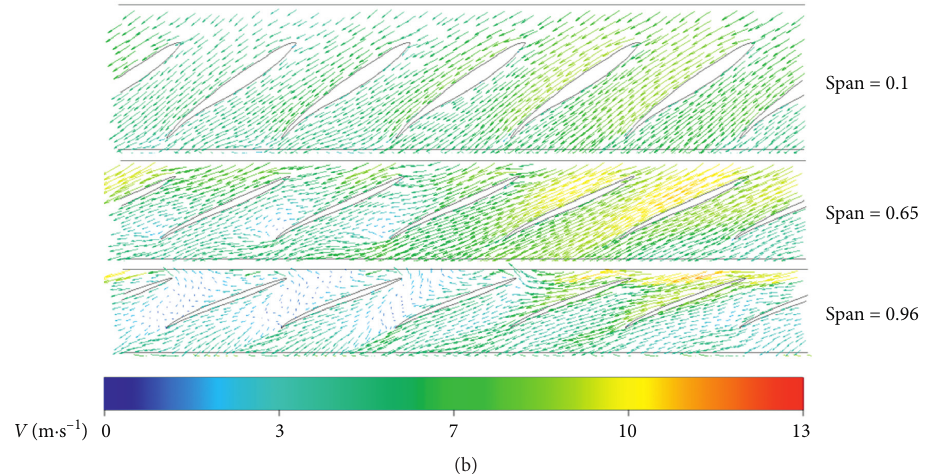
Figure 18: Velocity vector on each span of original scheme and selected scheme under 0.67 Q ′ condition: (a) original scheme; (b) selected scheme.